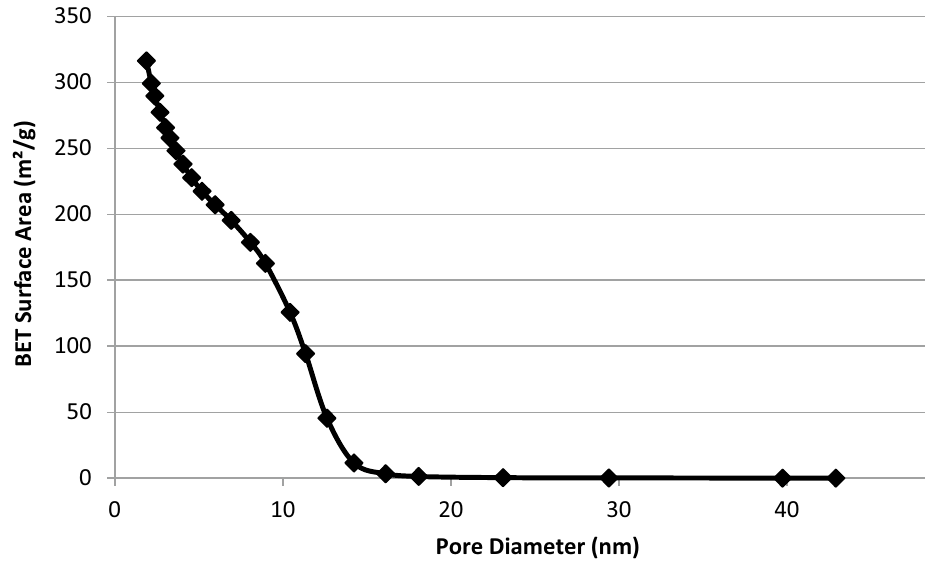
Figure 8. Brunauer–Emmet–Teller (BET) surface area distribution of silica nanoparticles synthesized from UKMRC-8 rice husk